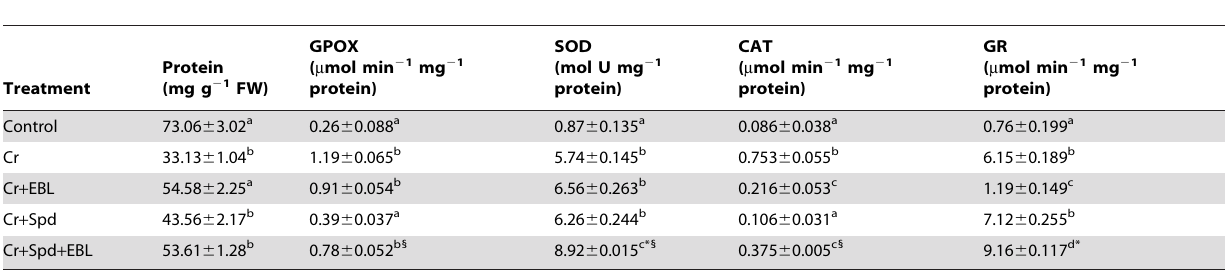
Table 3. Effect of EBL and/or Spd on protein content and specific activities of antioxidant enzymes in radish seedlings under Cr-